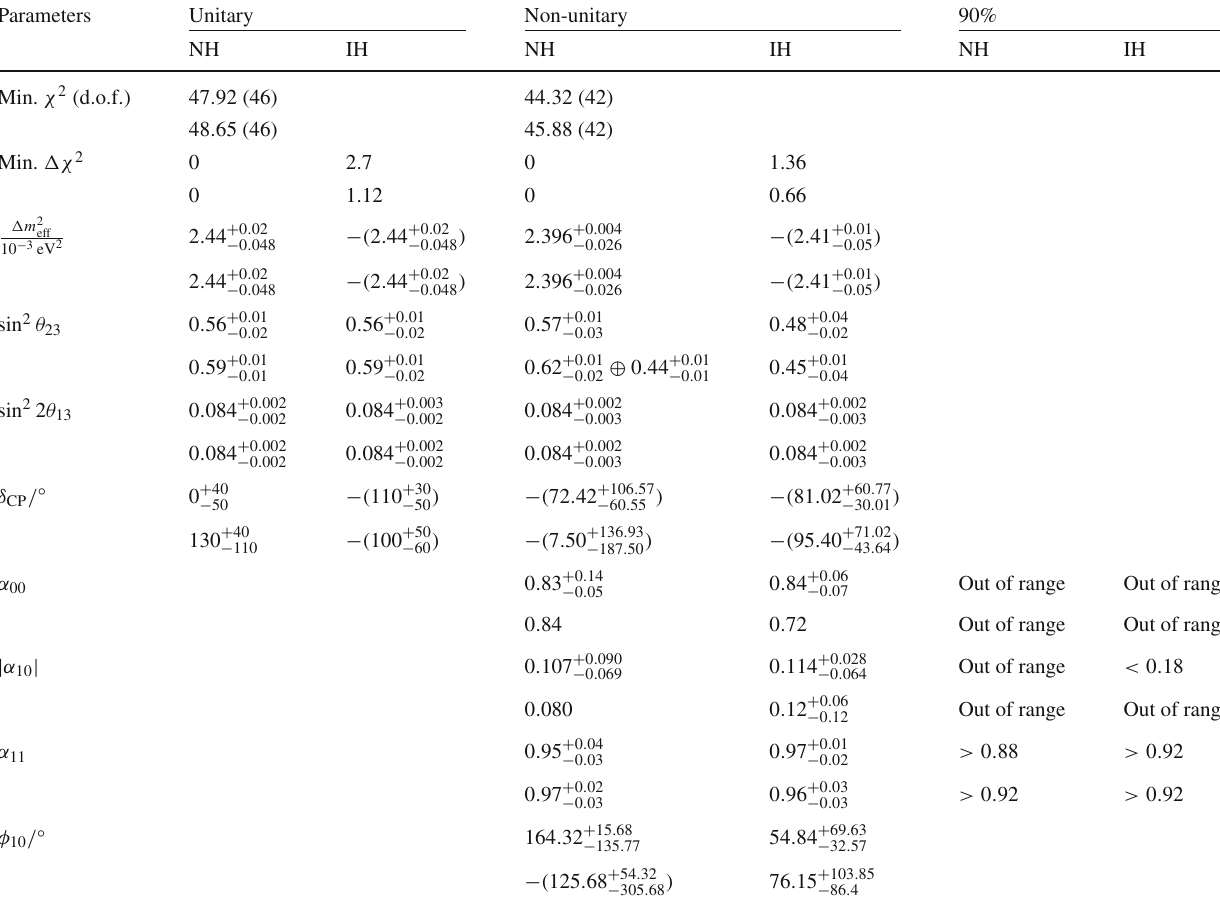
Table 1 Parameter values at the best-fit points for NO ν A.The 1 σ error bars have been mentioned where possible. The 90% limits for 1 d.o.f have also been mentioned. In each box, the result with 2019 (2020) data has been mentioned at the top (bottom) of the box Parameters